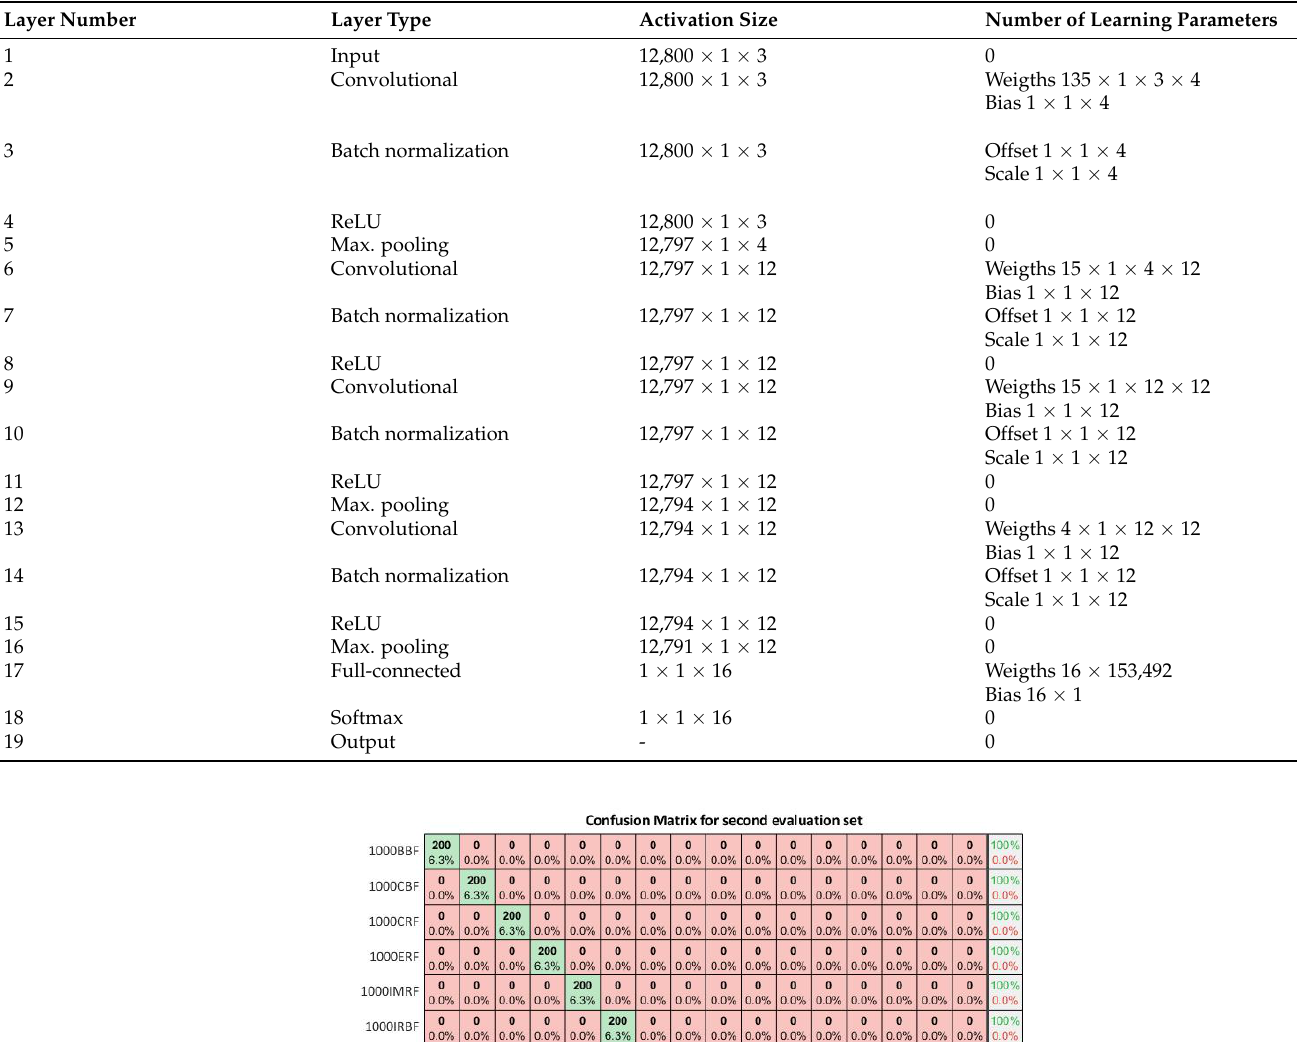
Table 7. CNN structure of optimal model for intelligent fault diagnosis.